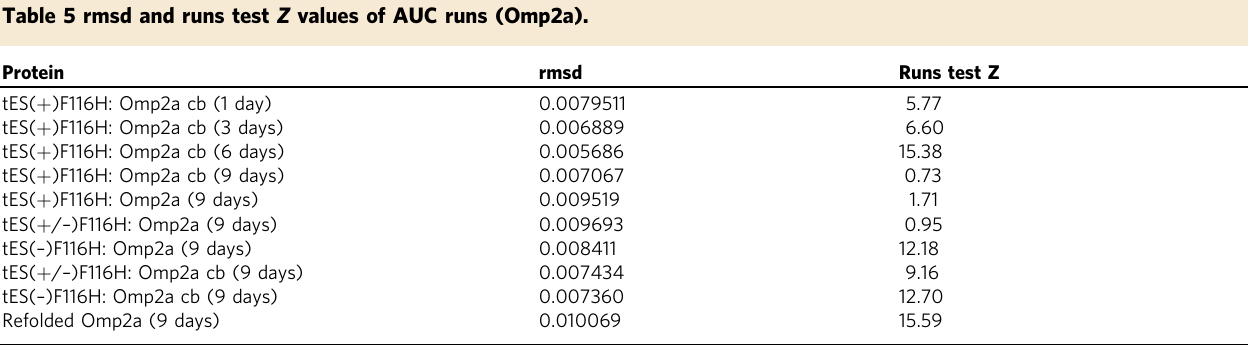
Determining the quality of fi t for AUC curve for Omp2a encapsulated, refolded and released from tES( + )F116H incubated for 1, 3, 6 and 9 days at 37°C, tES( + / – )F116H and tES(-)F116H and Omp2a refolded without tES, incubated at 37°C for nine days.